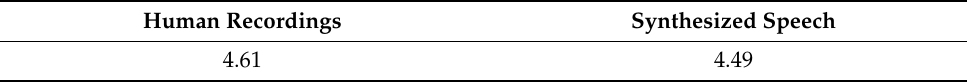
Table 6. MOS comparison between synthesized speech and human recordings.